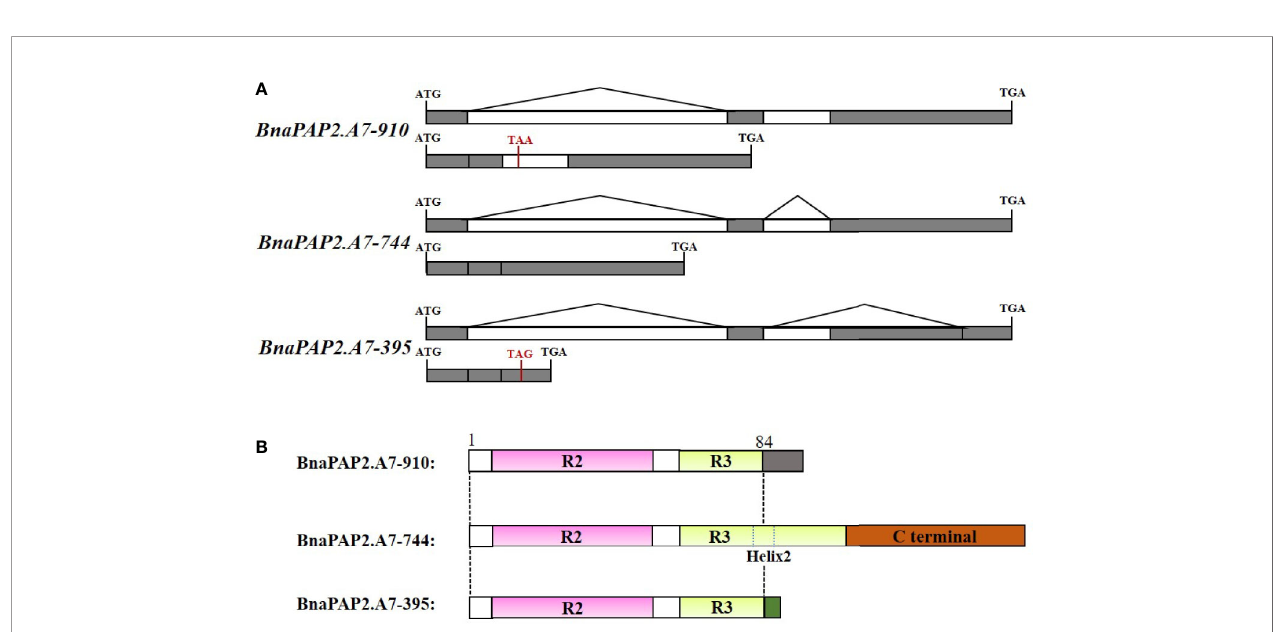
FIGURE 5 | Production, gene structure, and proteins sequence of three isoforms of BnaPAP2. A7 . PR. (A) Production and gene structure of the three isoforms. (B) Schematic diagram showing the protein sequence encoded by three isoforms. Gray and green boxes represent the new short C-terminal sequence that are completely different from those of original